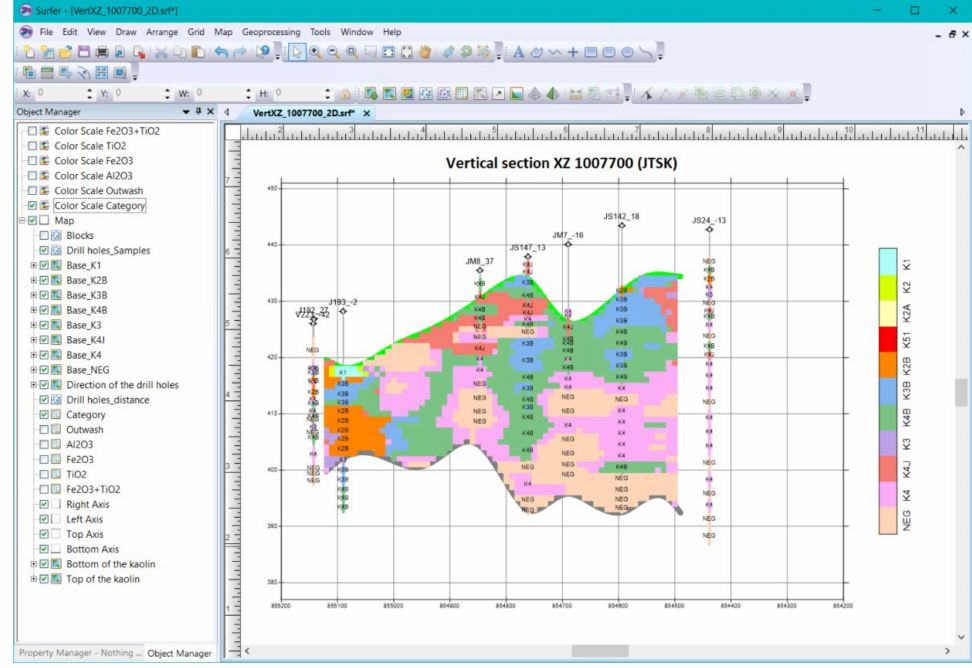
Figure 20. Visualization of vertical section XZ 1007700 in the Surfer